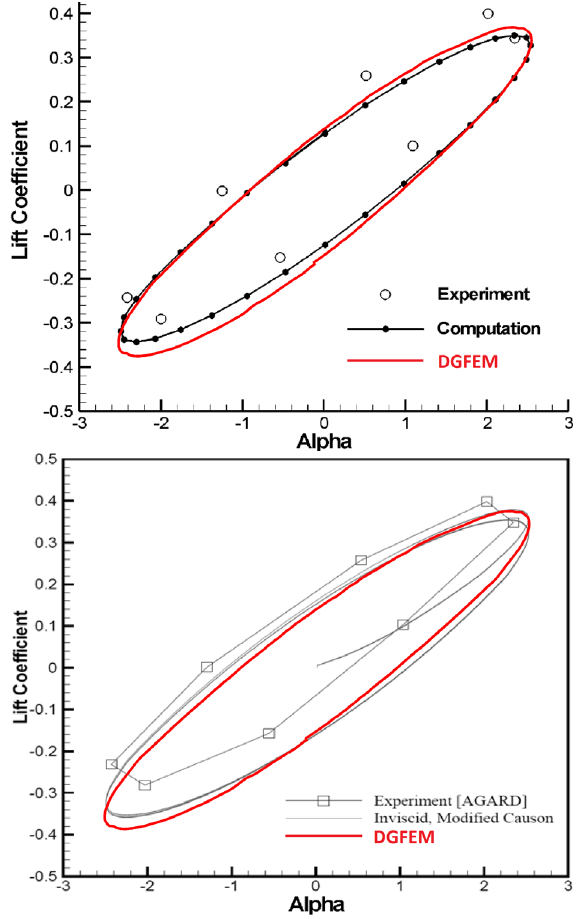
Fig. 1. Dependence of the lift coe ffi cient c L on the angle of the airfoil. Comparison with the numerical and experimental results published in [10] (top) and [11] (bottom).